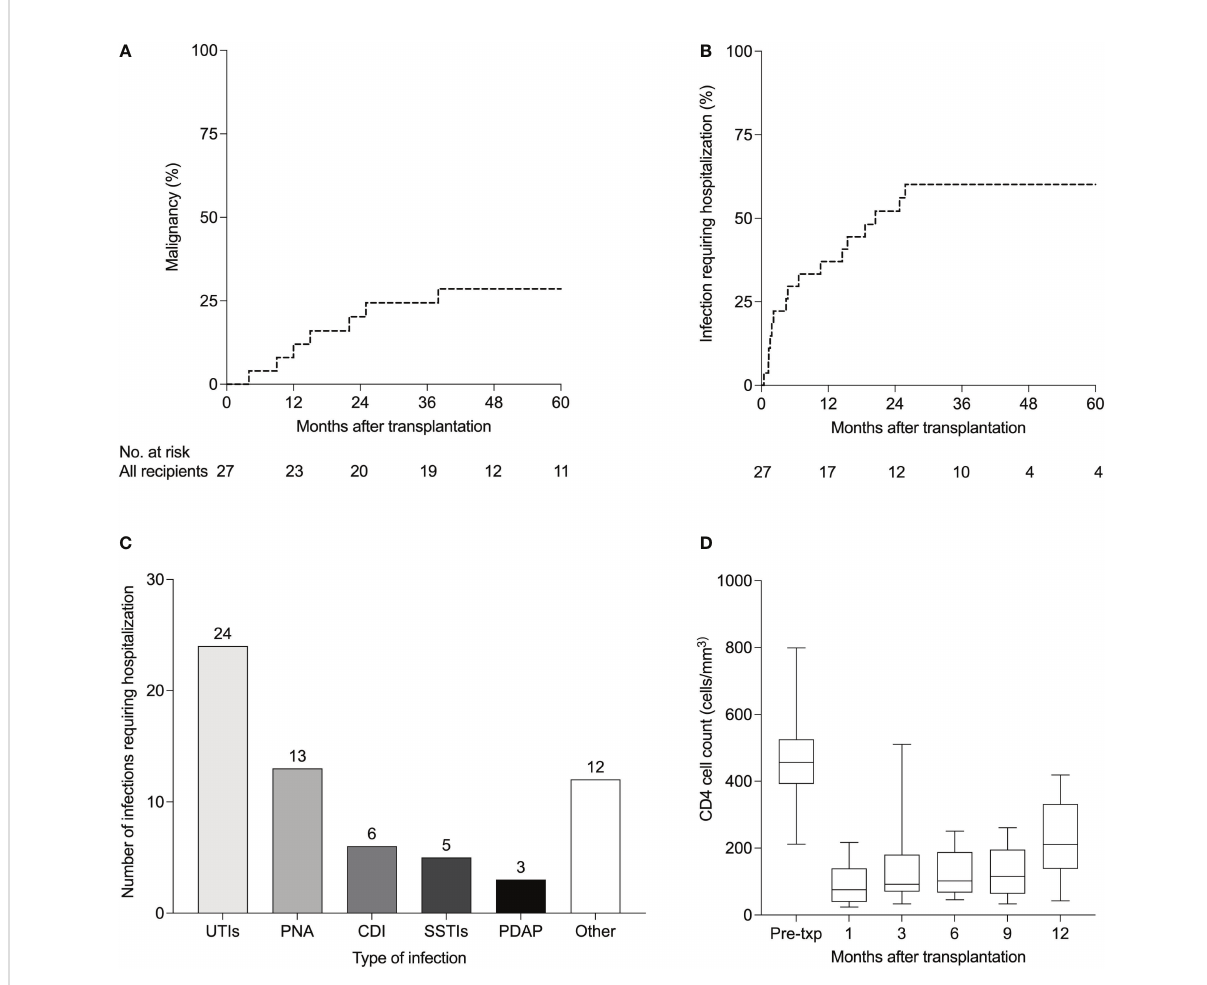
FIGURE 1 Complications of anti-thymocyte globulin induction in HIV-infected kidney transplant recipients (n=27). (A) Kaplan-Meier estimates of de novo malignancies and (B) infections requiring hospitalization after kidney transplantation. (C) Details of infections requiring hospitalization (B) in 27 HIV-infected kidney transplant recipients managed with. Other infections included cholecystitis (n=2), bacteremia (n=2), implantable cardioverter-de fi brillator infection (n=1), Candida glabrata fungemia (n=1), pulmonary tuberculosis (n=1), Pneumocystis jirovecii pneumonia (n=1), Rhinovirus (n=1), Cytomegalovirus colitis (n=1), liver abscess (n=1) and Shiga toxin-producing E coli (n=1). (D) CD4 cell counts (cells/mm 3 ) after kidney transplantation. Boxplots show the 10 th , 25 th , 50 th , 75 th , and 90 th percentiles. UTIs, urinary tract infections; PNA, pneumonia; CDI, Clostridium dif fi cile infection; SSTIs, skin and soft tissue infections; PDAP, peritoneal dialysis-associated